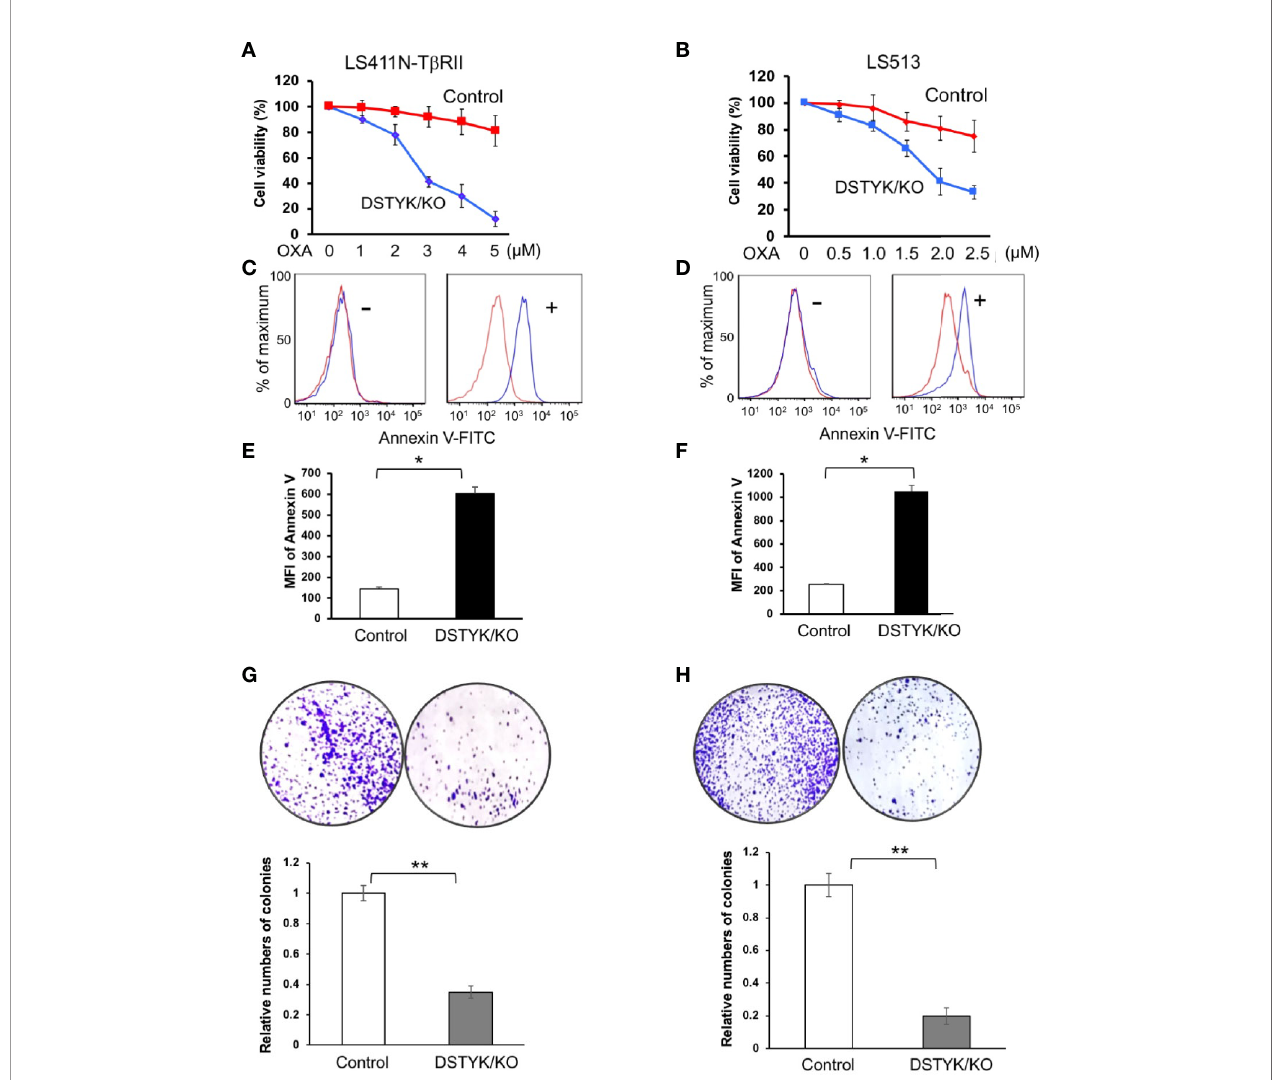
FIGURE 5 | DSTYK inhibits chemotherapeutic agent-induced apoptosis. (A, B) MTT assays to compare the chemoresistance between control and DSTYK/KO cells after 3 days OXA treatment. Data are presented as means ± SEM, for n > 3 per dosage point. (C, D) Flow cytometry analysis to compare the expression of cell surface apoptotic marker annexin v between control cells and DSTYK/KO cells after a 48 h OXA treatment, 4 µM in (C) ; 2 µM in (D) . Red curves represent control LS411N-T b RII cells or LS513 cells. Blue curves represent DSTYK/KO LS411N-T b RII cells or LS513 cells. ‘ - ’ means without OXA treatment. ‘ + ’ means with OXA treatment for 48h. (E, F) Quanti fi cation of the fl ow cytometry analyses in (C, D) , respectively. (G, H) Clonogenic assays and the corresponding quanti fi cation results. All experiments were repeated at least three times and similar results were observed. *P < 0.05; **P <